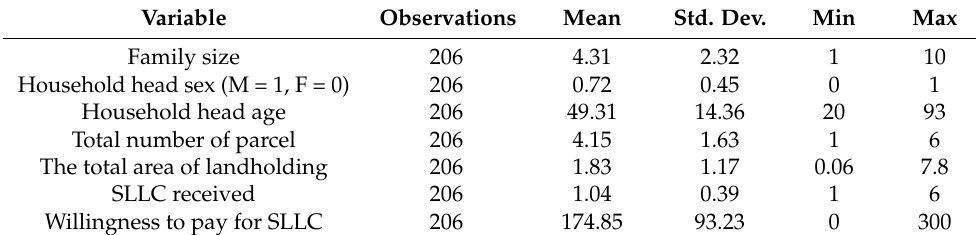
Table 3. Summary and descriptive statistics of selected